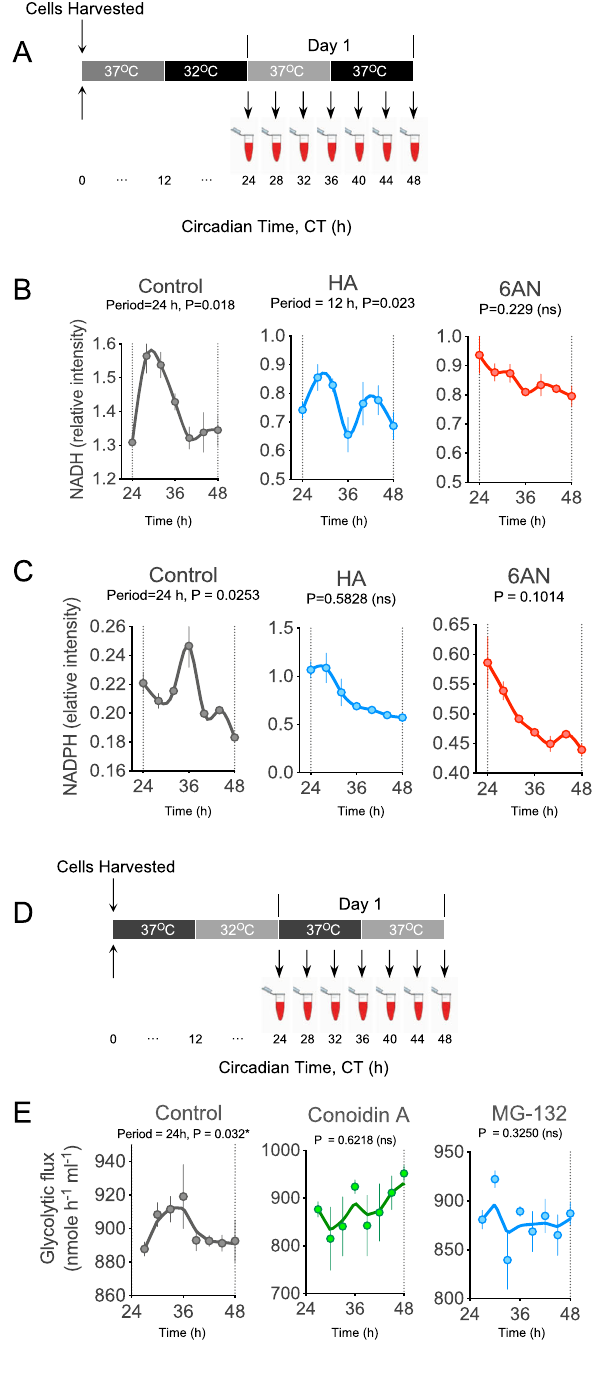
routing carbohydrate 52 . We have shown that inhibiting GAPDH results in arrhythmic metabolic fl uxes, which leads to arrhythmic redox balance as shown by fl at NADPH, NADH, and peroxir- edoxin oxidation pro fi les. Thus, our data suggest daily cross-talk of glucose metabolism and redox factors is required to maintain circadian oscillations in human RBCs. In eukaryotes, prevailing clock models revolve around transcription-translation feedback loops (TTFLs) 6 . How cell metabolism couples to rhythmic peroxiredoxin state and whether these metabolic rhythms are independent of TTFL was unclear.